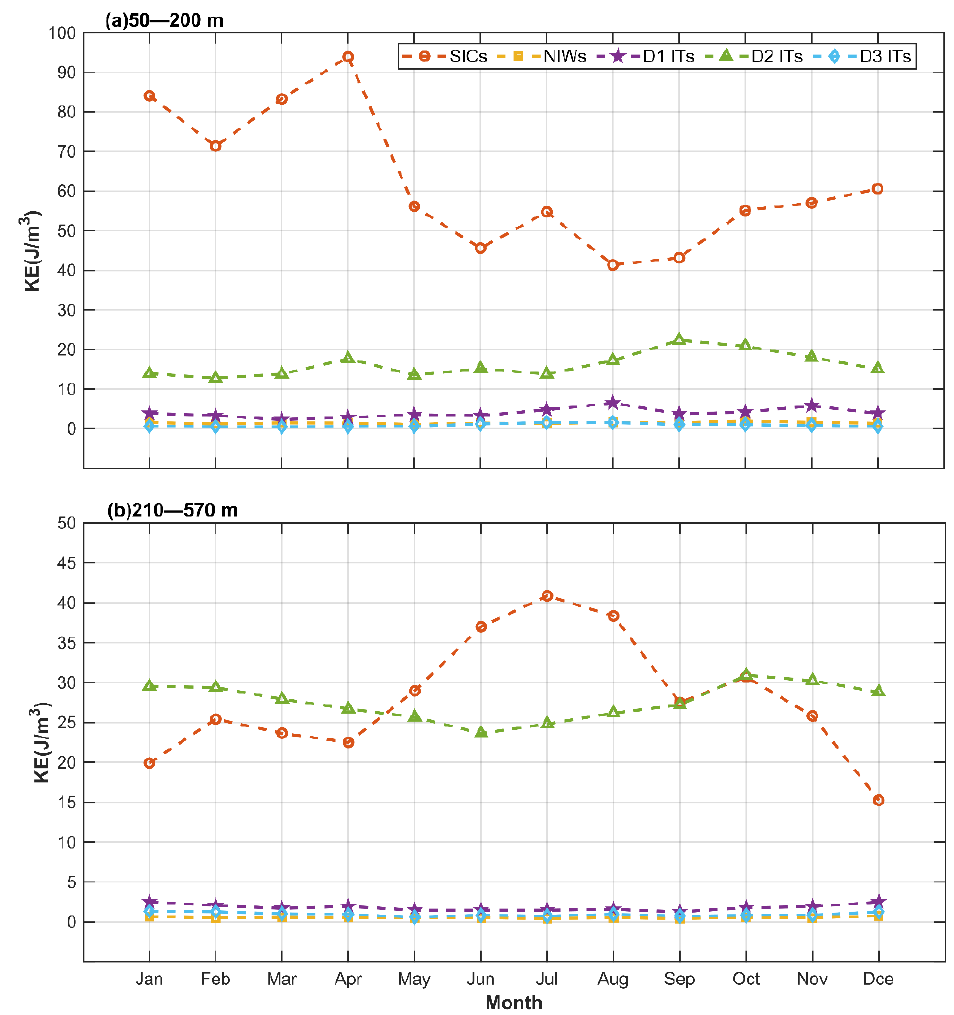
Figure 7. Seasonal evolutions of the depth-averaged kinetic energy densities caused by SICs (orange), NIWs (yellow) and D1 (purple), D2 (green), and D3 (light blue) ITs. ( a , b ) represent the shear averaged over 50–200 m and 210–570 m, respectively. Table 2. The seasonal depth-averaged shear (kinetic energy densities) caused by (of) SICs, NIWs, and Its, as well as their proportions (in brackets) in the sum of the shear (kinetic energy densities) in the different average depth